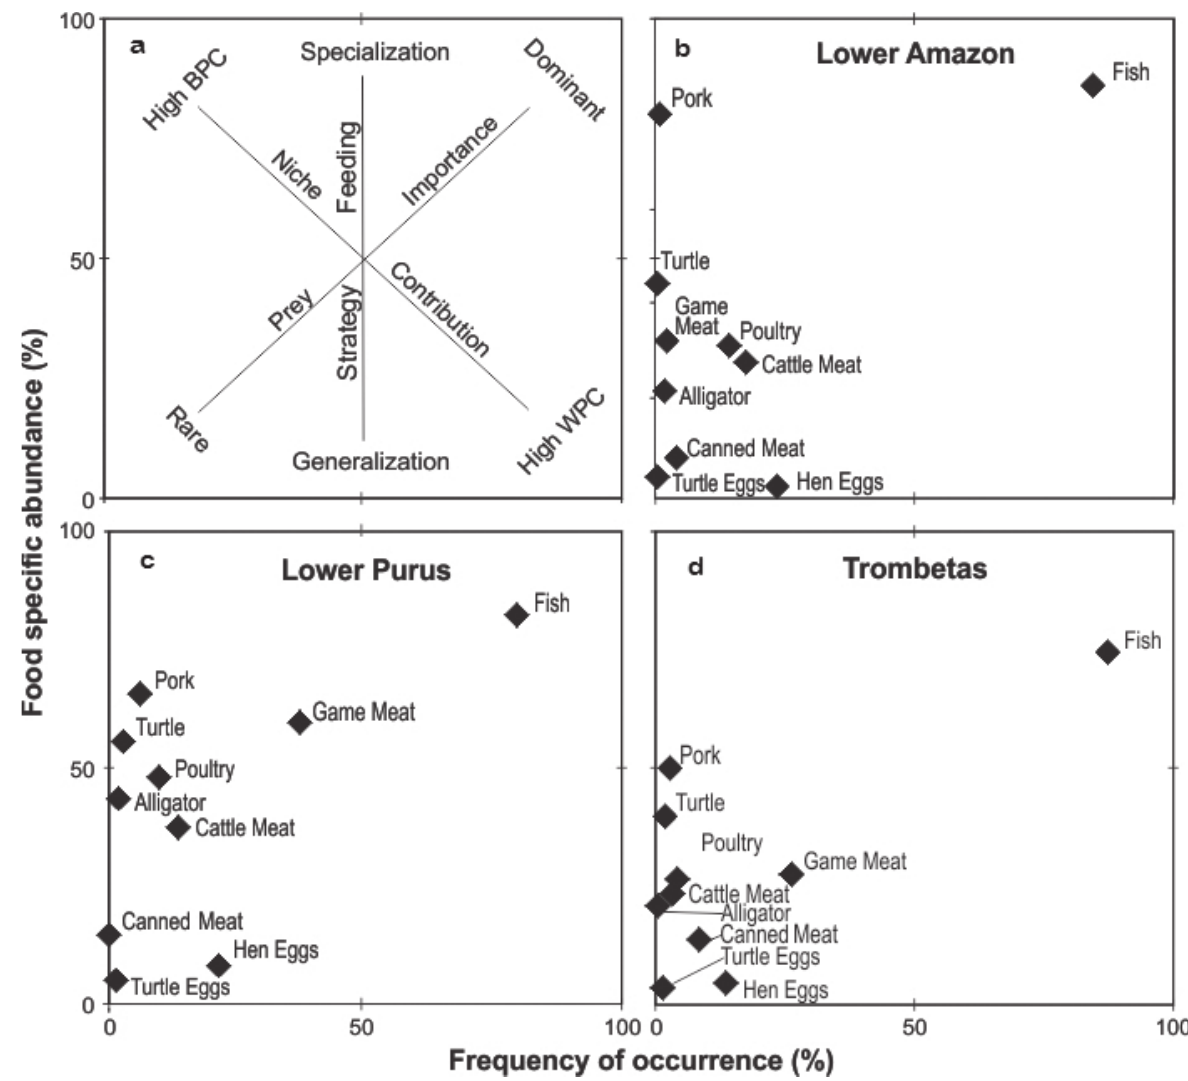
Figure 3 - ( a ) Explanatory diagram of the modified Costello method (BPC: between-phenotype component; WPC: within- phenotype component). ( b - d ) Variation of feeding strategies in the study